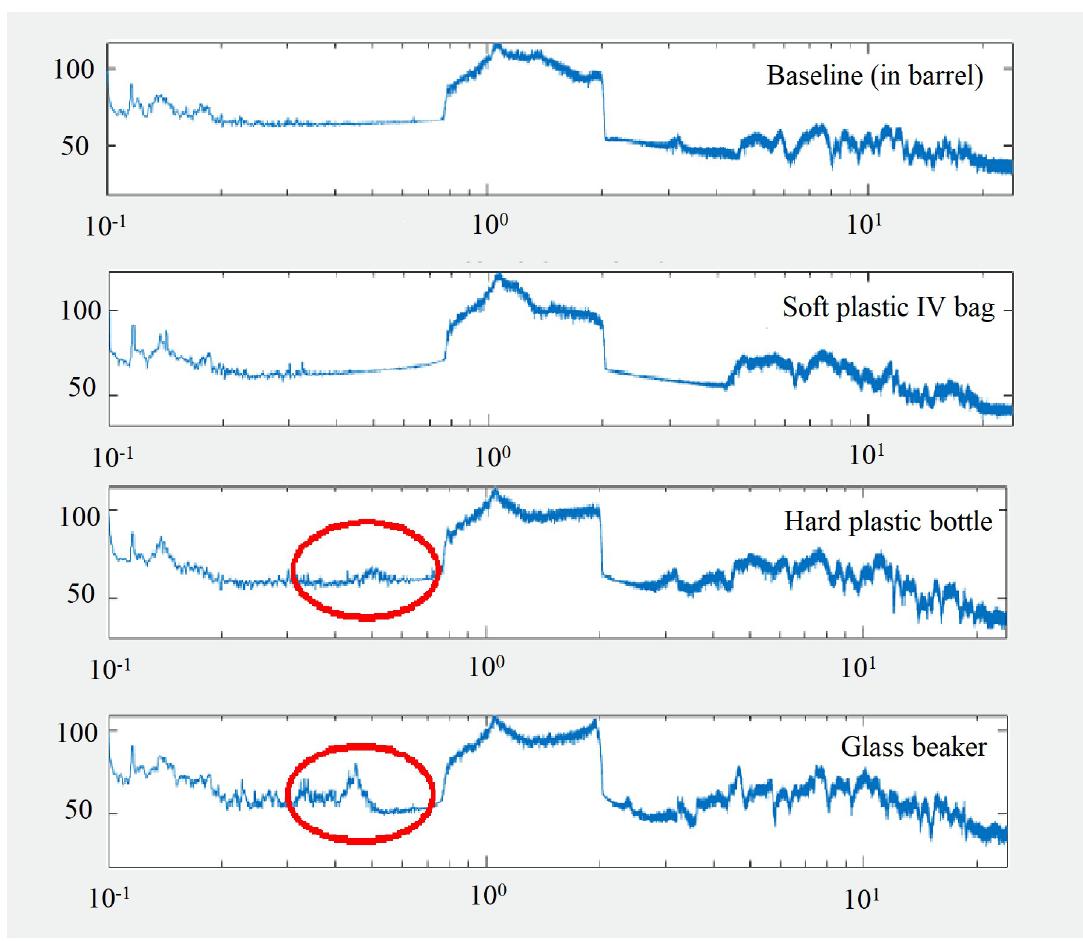
Fig 2. Comparison of 0.8–2 kHz sound transmission into three different culture vessels. Sound spectra are plotted as frequency (kHz; x-axis) versus sound intensity (dB re 1 μ Pa 2 @ 1 m; y-axis) for baseline in the barrel, and for the soft plastic IV bag, hard plastic bottle, and glass beaker culture vessels following application of 0.8–2.0 kHz white noise. Red circles highlight noticeable sound interference or resonance found for the glass beaker and hard plastic bottle in the 0.2–0.7 kHz